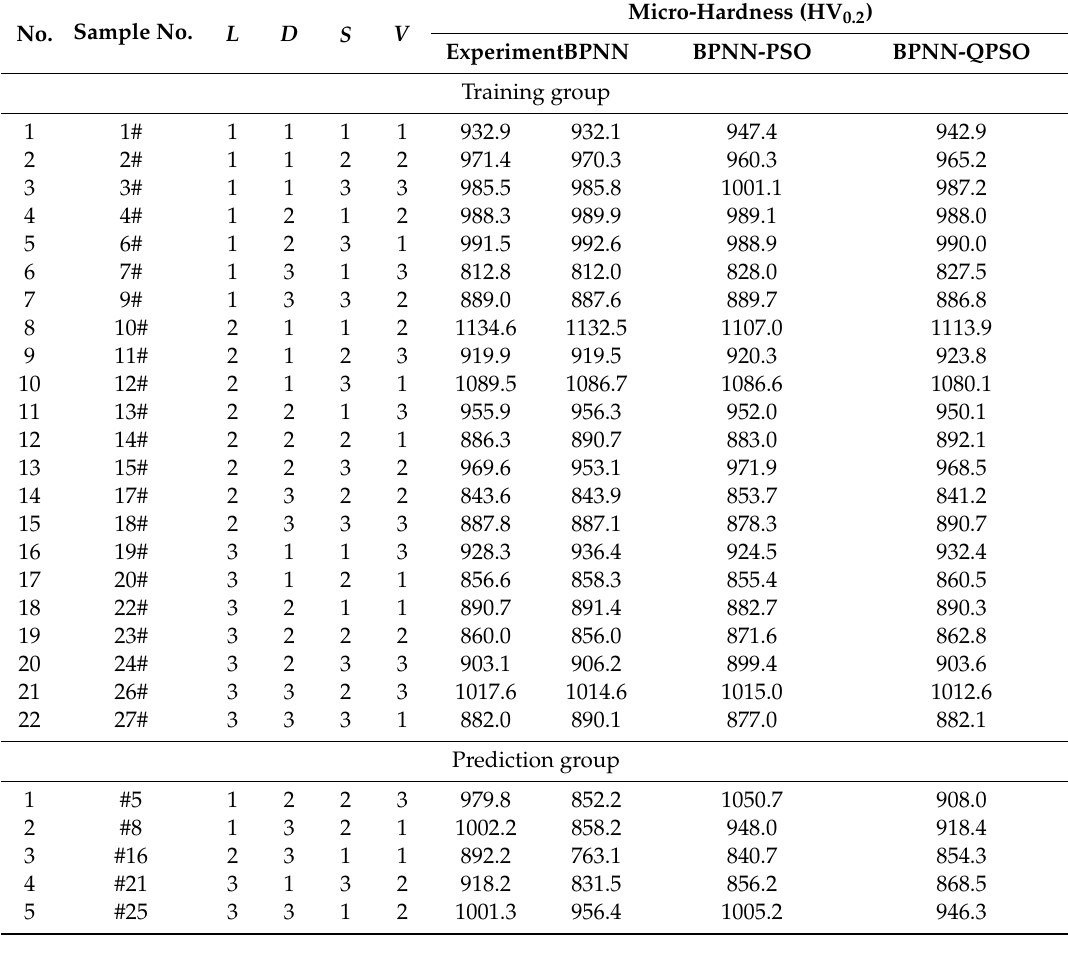
Figure 6. Cross-section of Ti(C, N) ceramic coating. Table 3. The micro-hardness of the coatings from experiments and models.